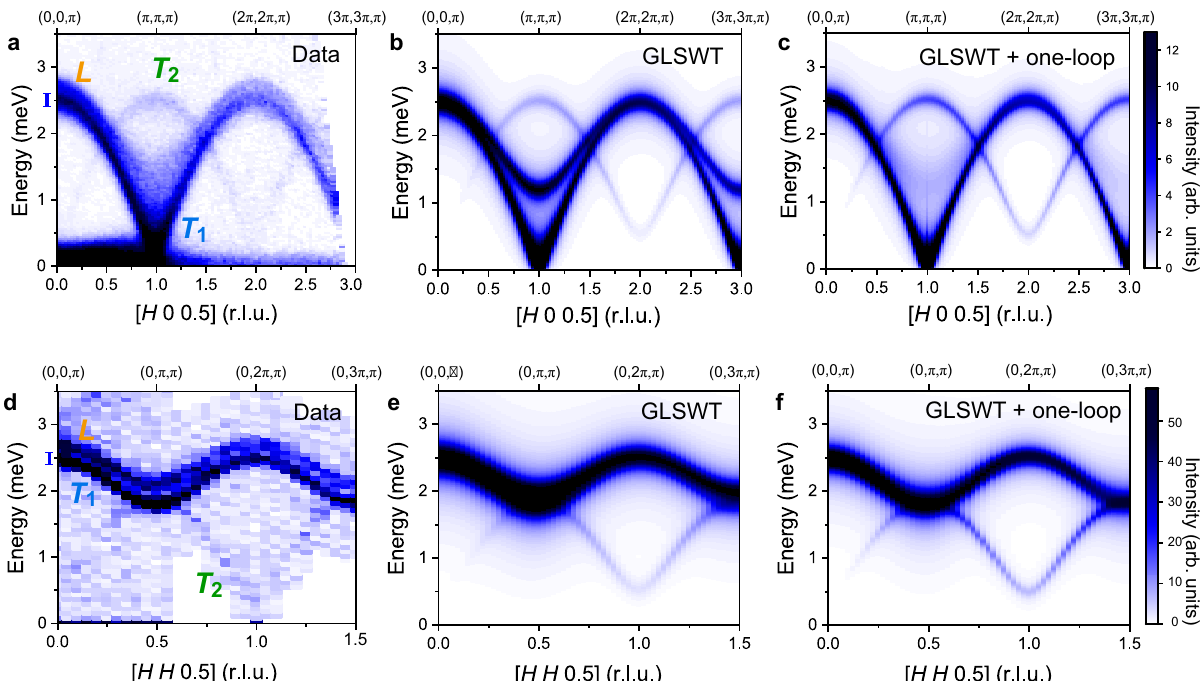
Fig. 3 Inelastic neutron scattering of Ba 2 FeSi 2 O 7 . a Contour map of the inelastic neutron-scattering (INS) data as a function of energy and momentum transfer along the [ H , 0, 0.5] direction measured at T = 1.6 K ( < T N ) using the HYSPEC time-of- fl ight spectrometer at SNS. d Contour map of the INS data as a function of energy and momentum transfer along [ H , H , 0.5] direction measured at T = 1.4 K ( < T N ) using the cold Neutron Triple-Axis spectrometer (CTAX) at HFIR. The instrumental resolutions at energy = 2.5 meV for each instrument are indicated with blue bars along the y -axis in a and d . The two transverse modes and the longitudinal mode are labeled with T 1 , T 2 , and L , respectively. b , c , e , f INS intensities calculated by the generalized linear spin- wave theory (GLSWT) and GLSWT plus one-loop corrections (GLSWT + one-loop) with the parameter sets A and B given in Table 1, respectively. The instrumental resolution of HYSPEC and CTAX was modeled in the calculated spectra using a Lorentzian superexchange interaction J ð J 0 Þ . Δ ( Δ ′ ) is the intralayer (interlayer) uniaxial anisotropy and the last term represents the easy-plane single-ion anisotropy ( D > 0).